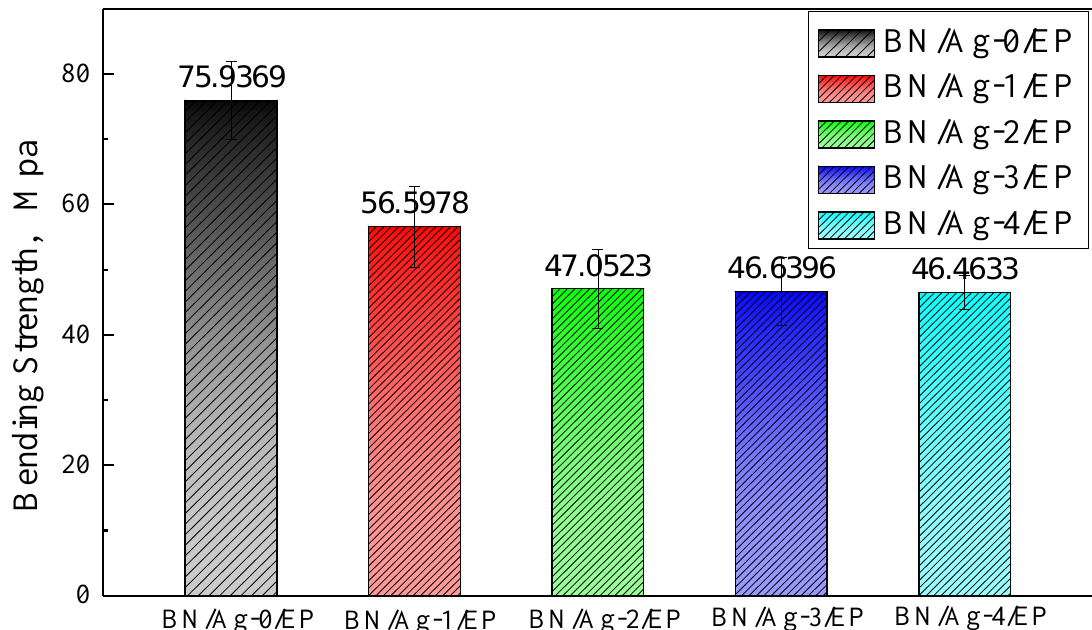
Figure 5. Bending strength of BN/AgNWs/EP composites.